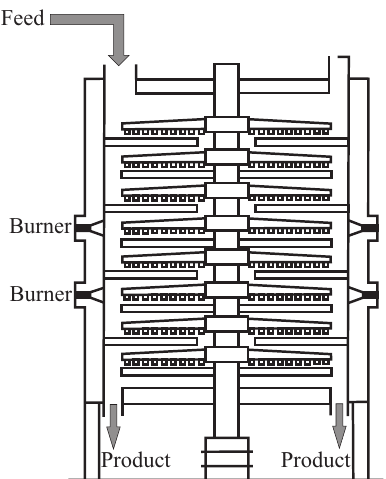
Figure 1. Schematic cross-section of a Multiple Hearth Furnace depicting the location of the feed inlet and product outlet, as well as the burners that control the temperature profile (Reproduced after Eskelinen et al. [3], with